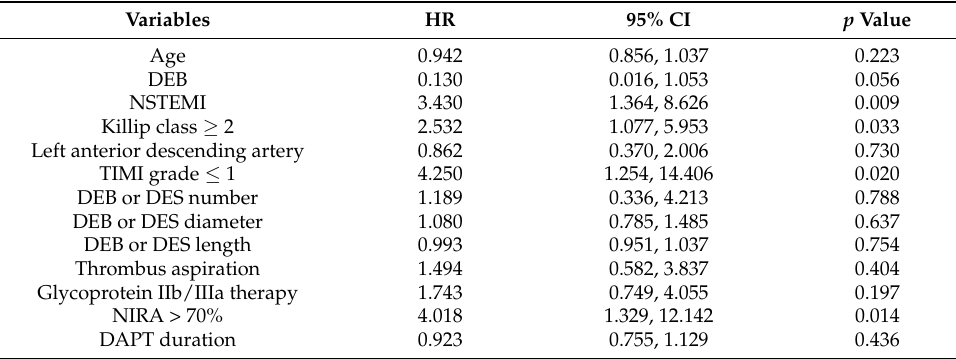
Table 4. Multivariate regression analysis of the predictors for